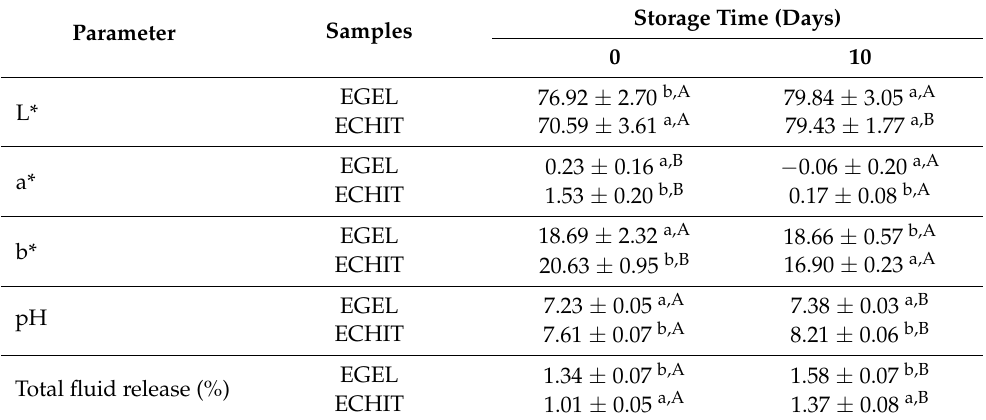
Table 2. Color parameters (L*—lightness, a*—redness and b*—yellowness), pH and total fluid release of gelatin (EGEL) and chitosan (ECHIT) emulsion gels at 0 and 10 days of storage at 4 ◦ C *. Parameter